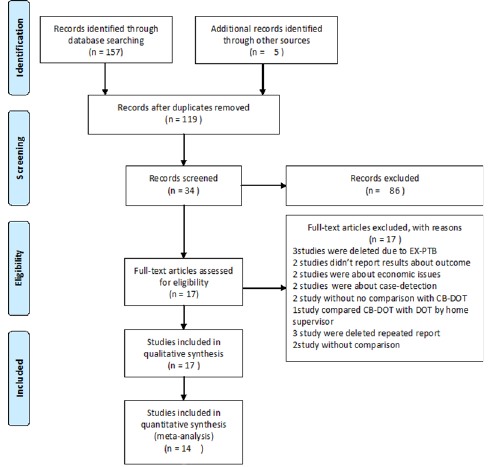
Fig 1. Results of literature search. This figure is a description of the full search process.